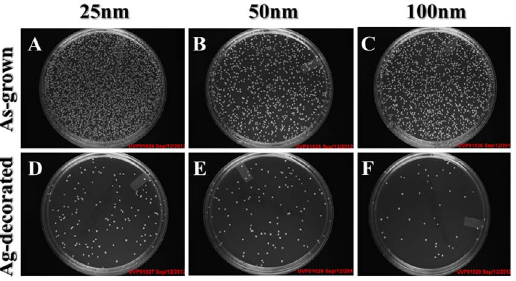
Figure 6. Photographs of the antibacterial activity test. Plates with S. aureus were grown in the presence of as-grown ( A – C ) and Ag- decorated ( D – F ) TiO 2 nanotubes of different diameters.